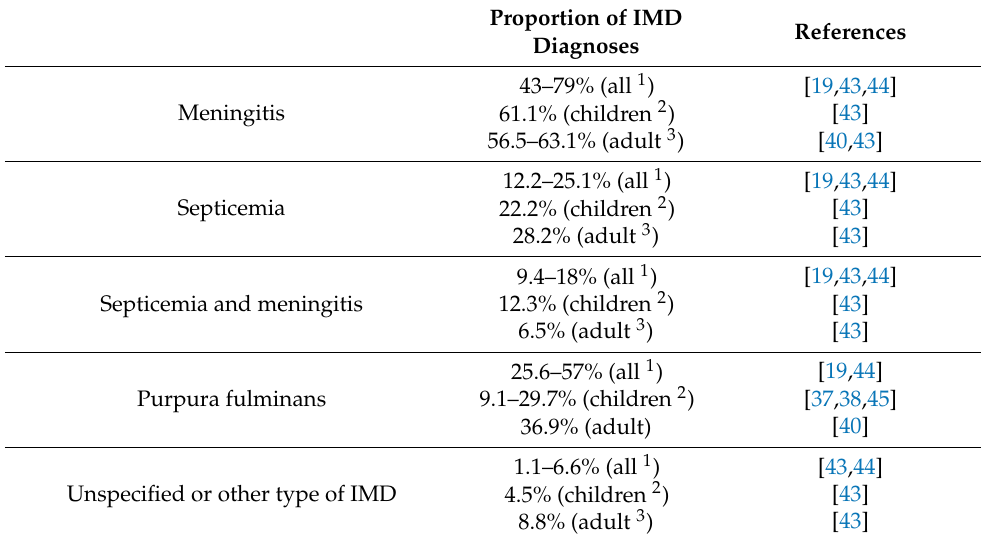
Table 1. Distribution of clinical presentation of IMD by age group in France.